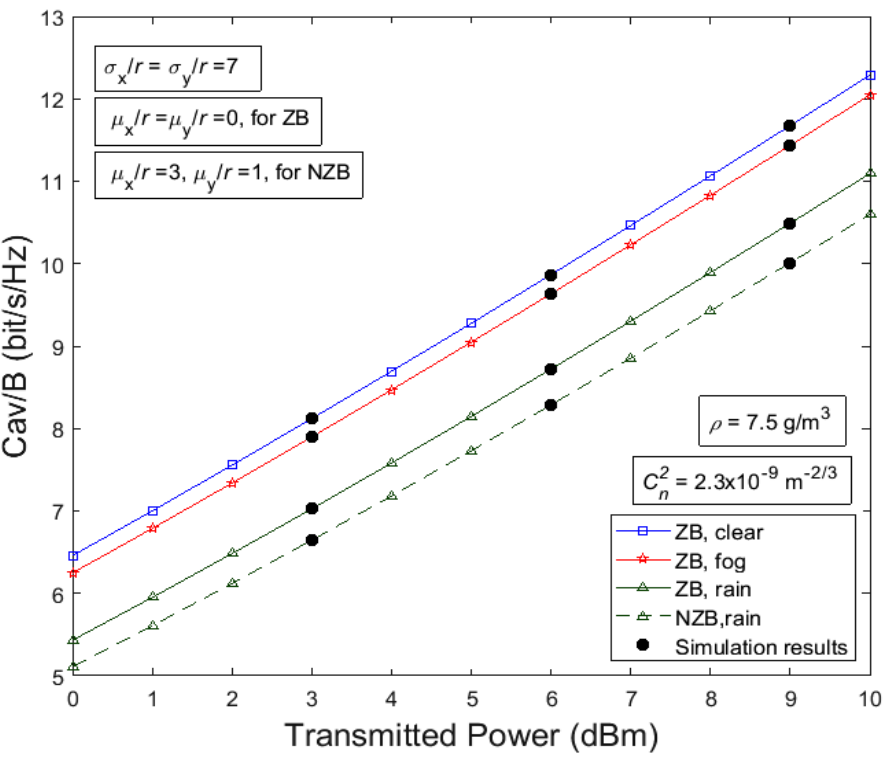
Figure 1. Average capacity (C av /B) versus transmitted power for strong turbulence, moderate water vapor concentration, and strong PE.